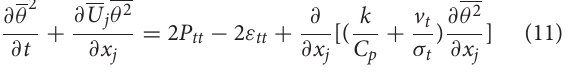
Frontiers in Energy Research |